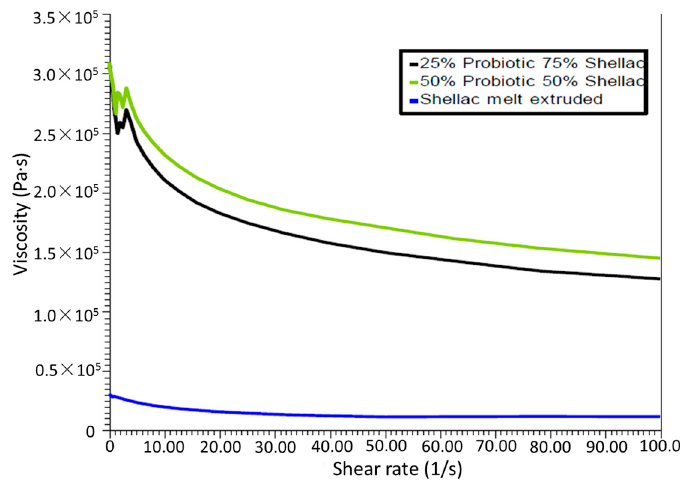
Figure 6. Viscosity versus shear rate at 70 °C of samples produced with SSB ® 55 shellac and Biocare ® Bifidobacterium Probiotic blends.